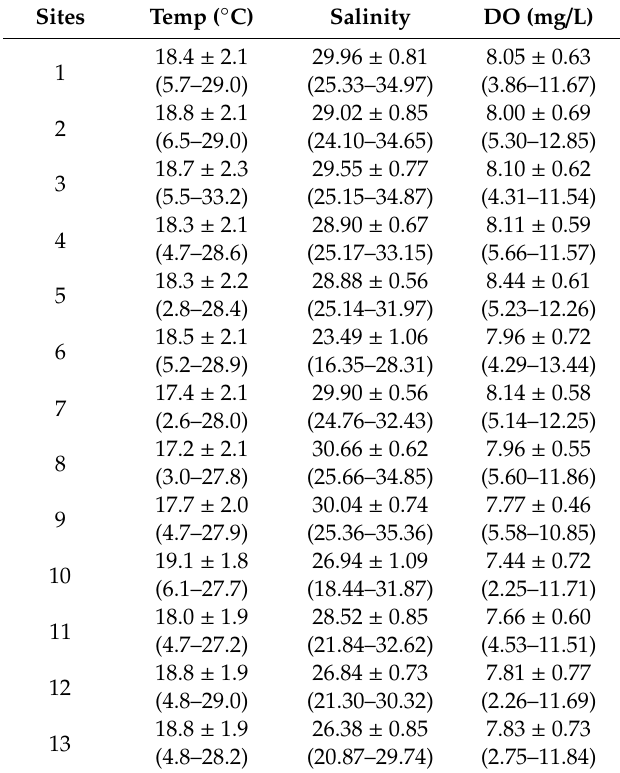
Table 2. Mean ( ± SE) and ranges of environmental parameters investigated during the study averaged from July 2014 to October 2017.